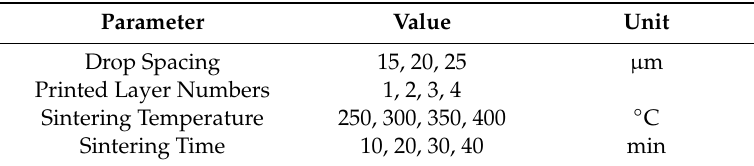
Table 2. Experimental printing